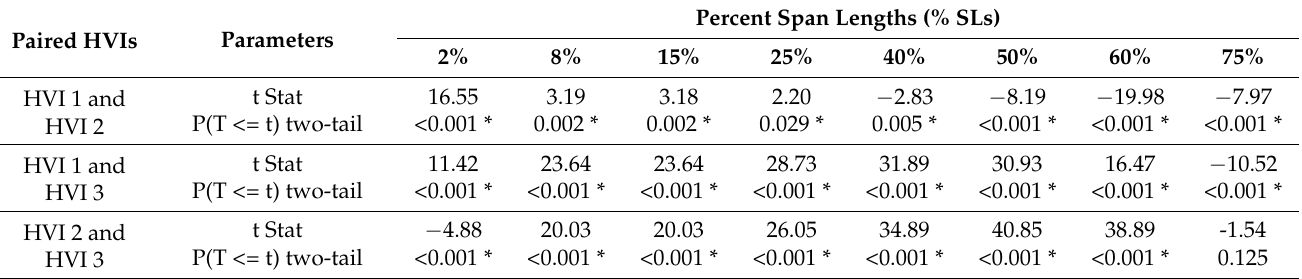
Figure 7. Three representative fibrograms of a sample measured with different HVIs. In Figure 7, visible differences in the fibrograms are observed among instruments. Table 1. Summary of a paired t -test ( α = 0.05) of length measurements between HVIs for all possible These differences are concentrated in the fibrogram portion between 10% and 70% SL. combinations of Similar differences are observed across HVIs for all samples. As the extracted fibrograms